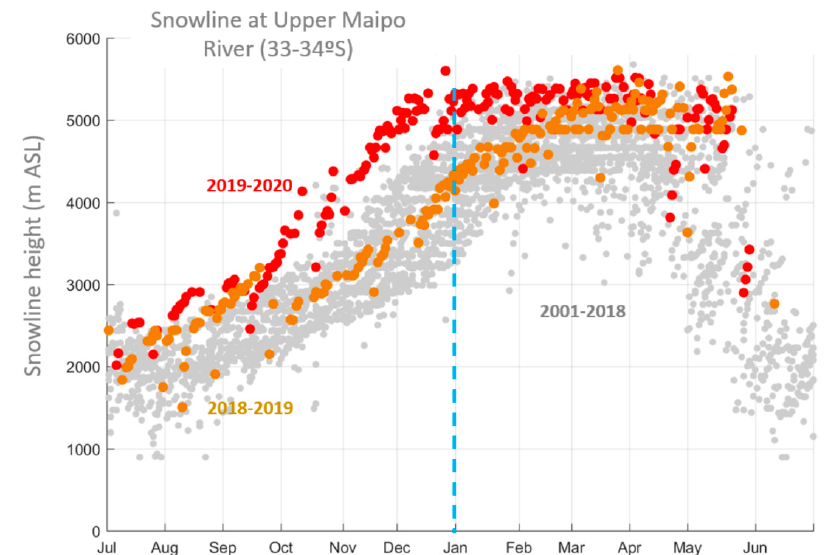
Figure 1. Variability and trends in central Chile’s hydroclimate since 1960. The light-blue bars are the annual precipitation for the city of Santiago (Quinta Normal) from 1960 up to the early spring of 2020 (and hence including the previous winter months when most precipitation is received). The horizontal dashed line is the long-term mean. Extreme drought years for the period (highly reduced precipitation in the winter months) of 1968, 1998 and 2019 are highlighted in red. The central Chile mega drought (from 2010 onwards) is also identified. The orange line with yellow circles gives the average daily maximum temperature over the late spring–early summer months (November– December) for a given calendar year and the mid–late summer months (January–February) for the following calendar year (so as to capture the austral summer). All values are plotted with respect to the calendar year of November and December The last summer season (November–December 2019, January–February 2020) is highlighted by the red dot, which according to the convention adopted, is plotted for the year 2019. The last value is representative of the 2020 austral summer. Data source: downloaded from the CR2 climate explorer (http://explorador.cr2.cl/).